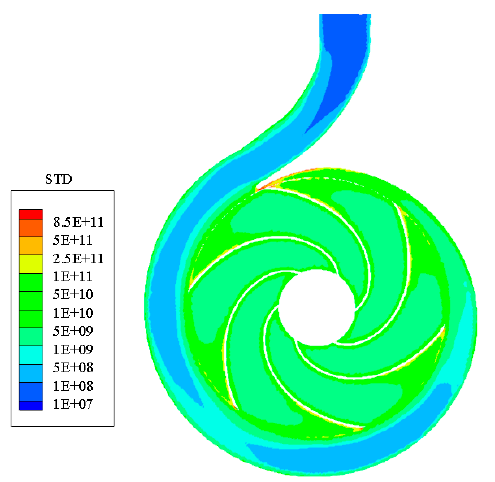
Figure 7. The standard deviation (STD) distribution characteristics of overall acoustic source.